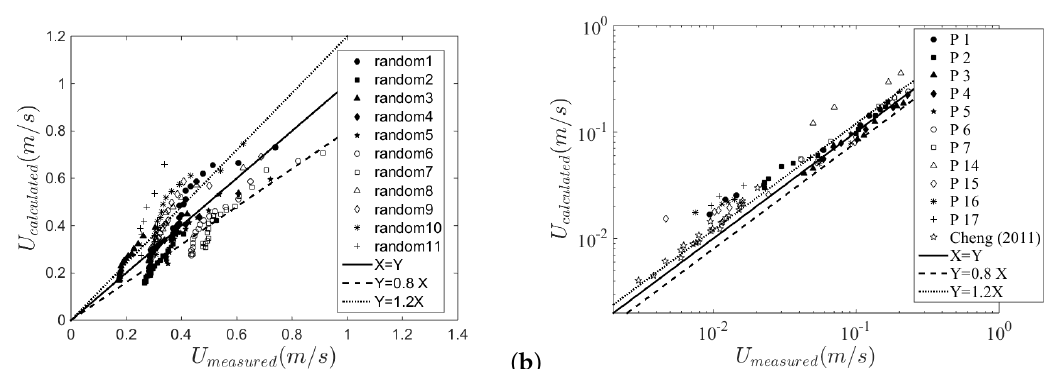
Figure 8. Comparison between the model and the experimental bulk velocity from [18] ( C d 0 = 0.3), R 2 = 0.59 ( a ), from [22] ( C d 0 = 0.7) , R 2 = 0.78 and from [21] ( C d 0 = 1) ( b ). The series correspond to various slopes, diameters, and concentrations tested in each